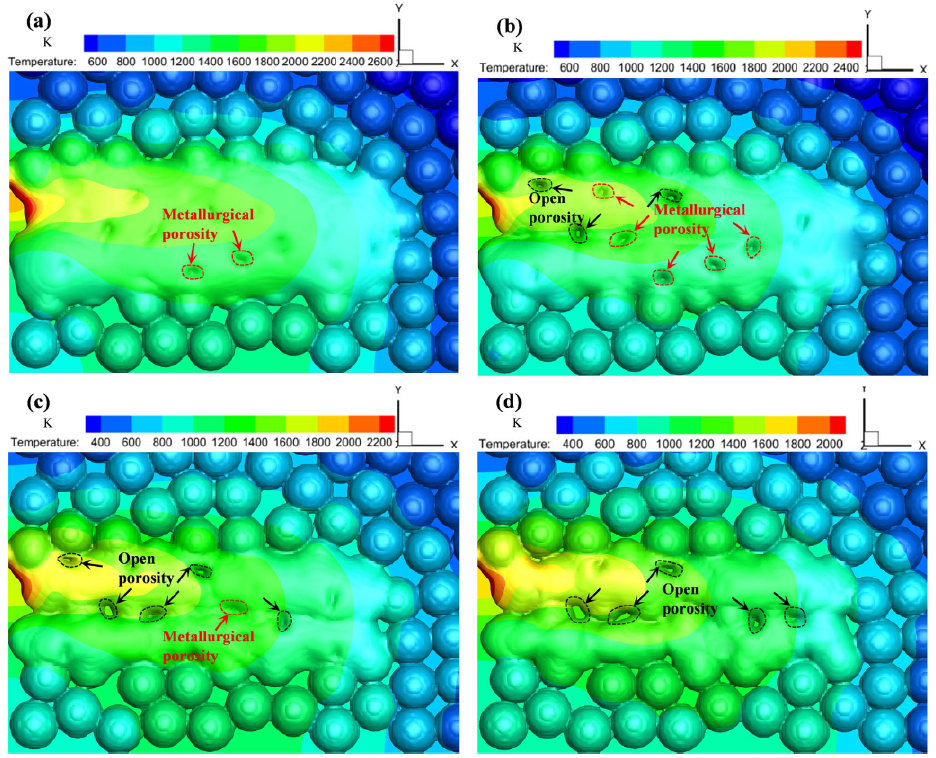
Figure 12. Evolution of calculated porosity on the top surface at various scanning speeds: ( a ) 200 mm/s; ( b ) 300 mm/s; ( c ) 400 mm/s; ( d ) 500 mm/s